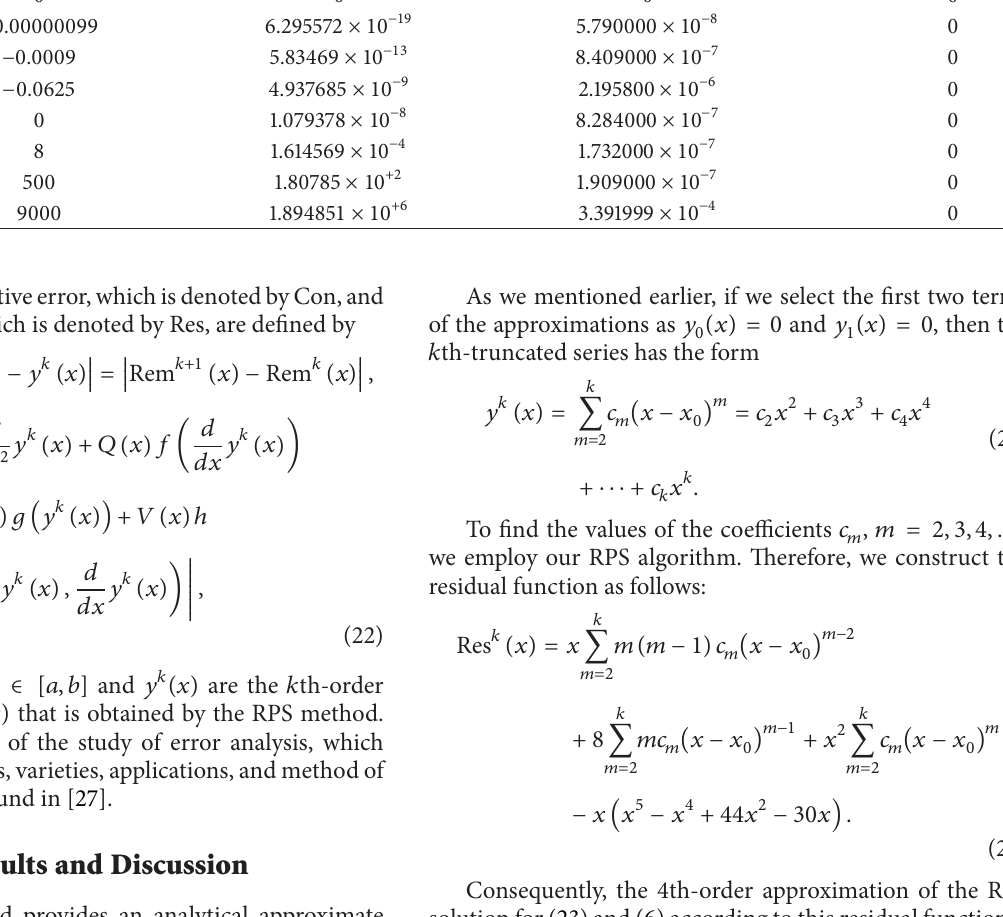
Table 1: A numerical comparison of the exact error function Ext 𝑘 (𝑥) to Example 1 for different values of 𝑥 in [0,10] . 𝑥